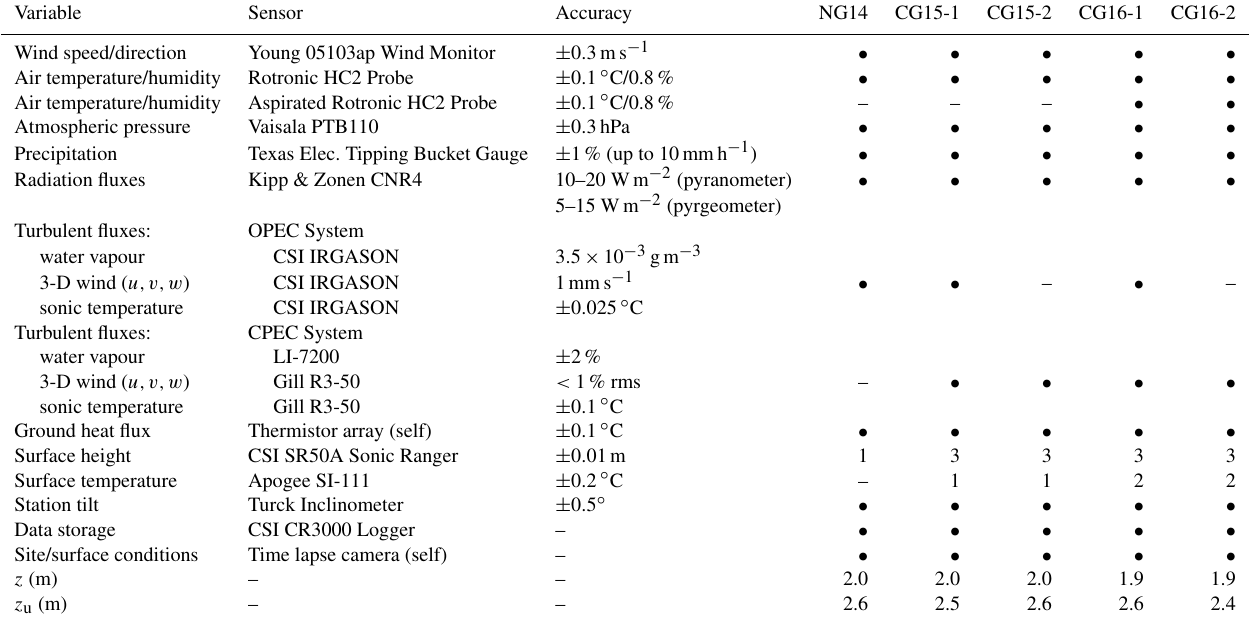
Table 2. Instrument list for each deployed station, including sensor accuracy and heights of installation of the EC and temperature sensors ( z ), and the wind monitor ( z u ).